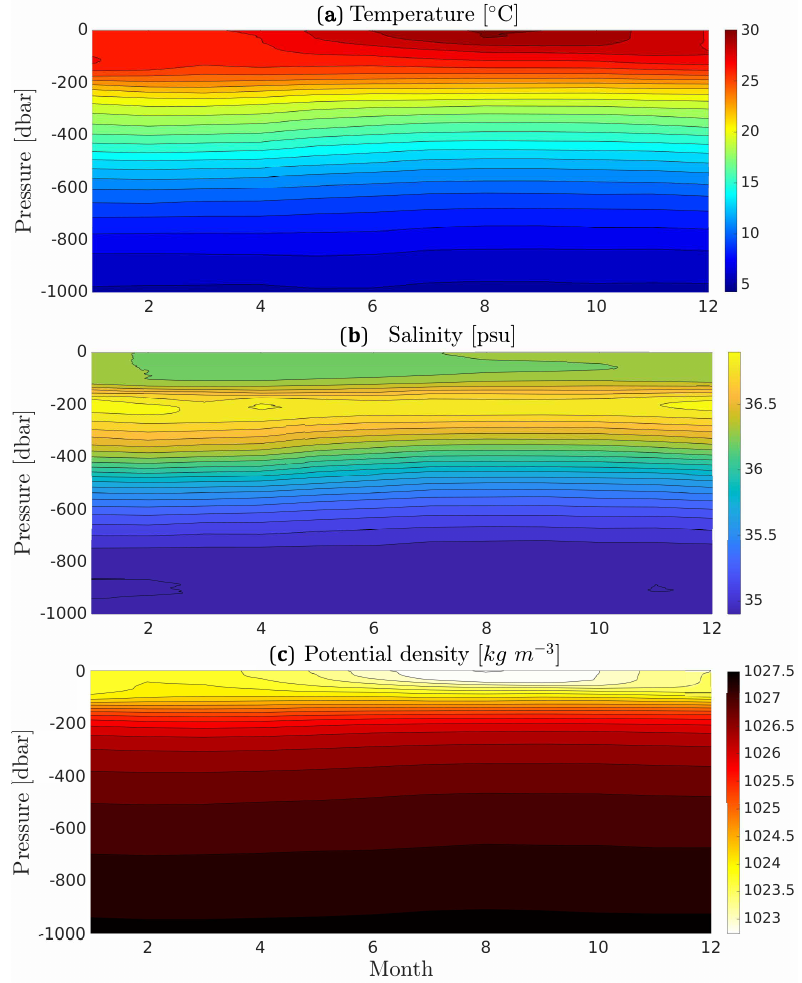
Figure 4. Example of seasonal variation of GEM fields for a given value of sea surface height (SSH; 0.8 m here). The x -axis is the time of year while the y axis is pressure. Temperature is shown in panel ( a ), salinity in panel ( b ), and potential density in panel ( c